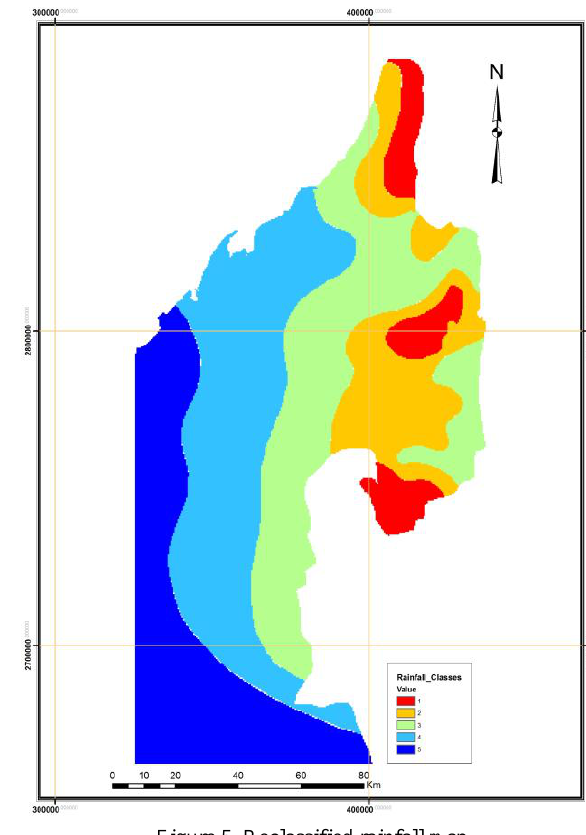
Figure 3. Slope map for the Northern part of UAE.